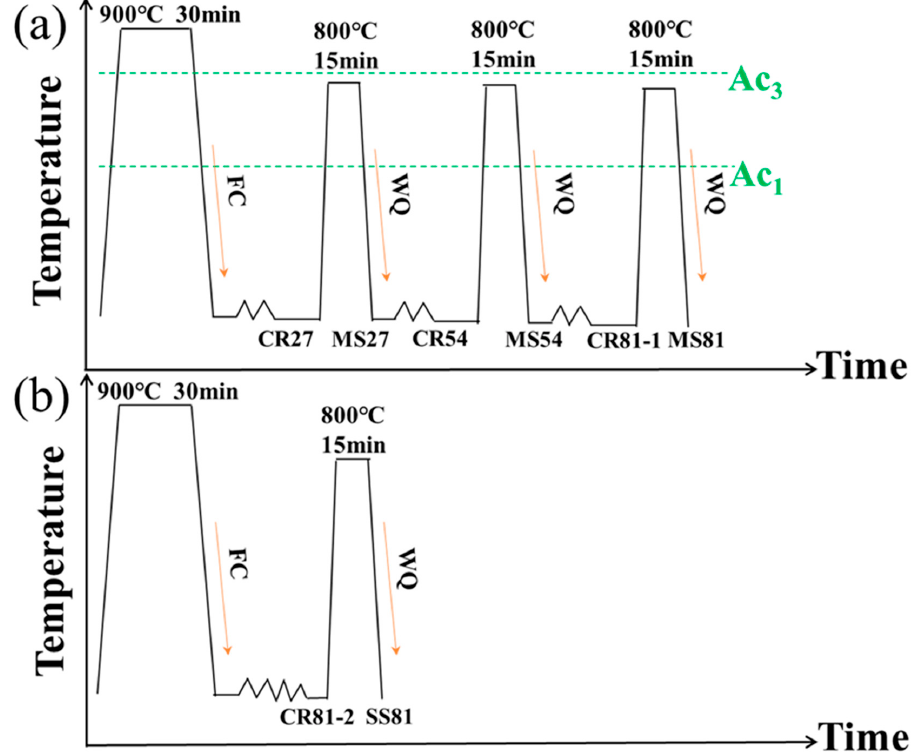
Figure 2. Schematic diagram of ( a ) multi-step and ( b ) single-step rolling and annealing process. Ae 1 : starting temperature of pearlite to austenite transformation during heating; Ae 3 : ending temper- ature of transformation to austenite after